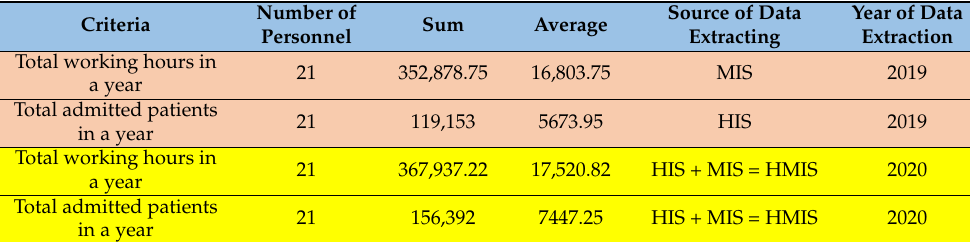
Table 1. Data extraction in 2019 and 2020.